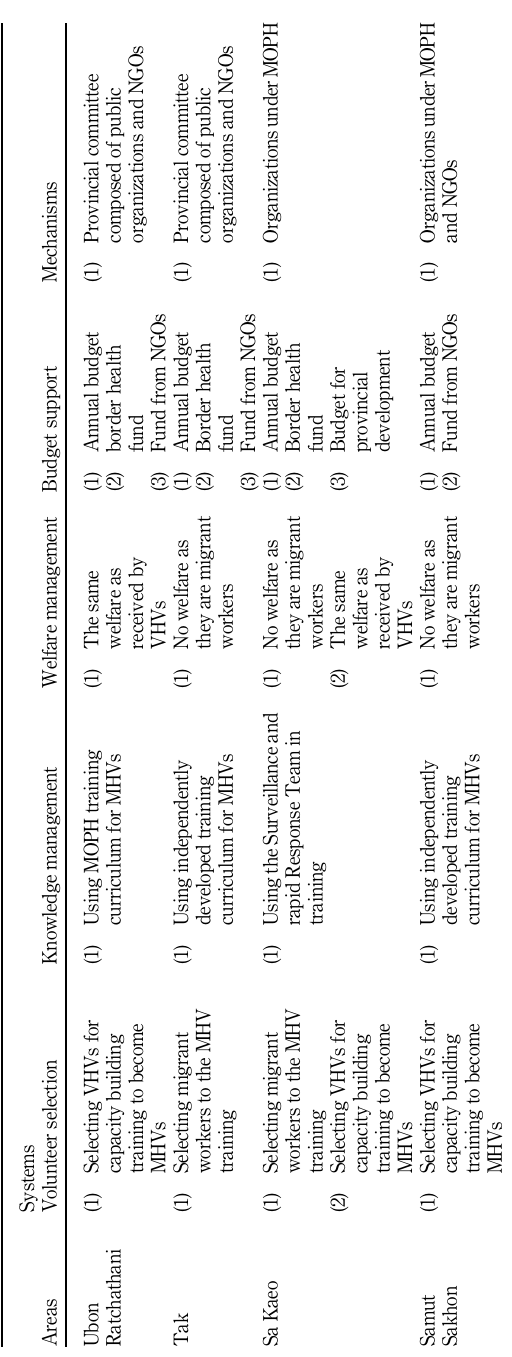
Table 2. Comparison of systems and mechanisms of the development of health volunteers for the healthoftheimmigrant workforce in four